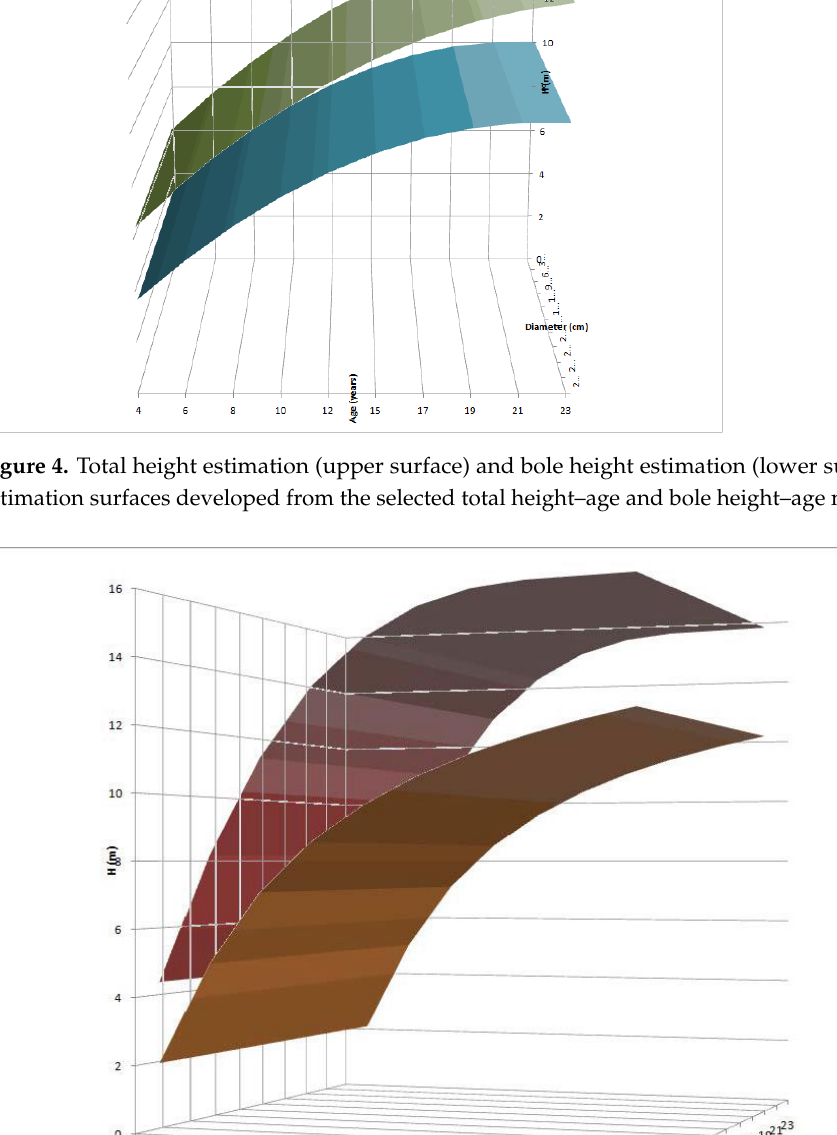
Figure 5. Total height estimation (upper surface) and bole height estimation (lower surface), with estimation surfaces developed from the selected total height – diameter and bole height – diameter models.